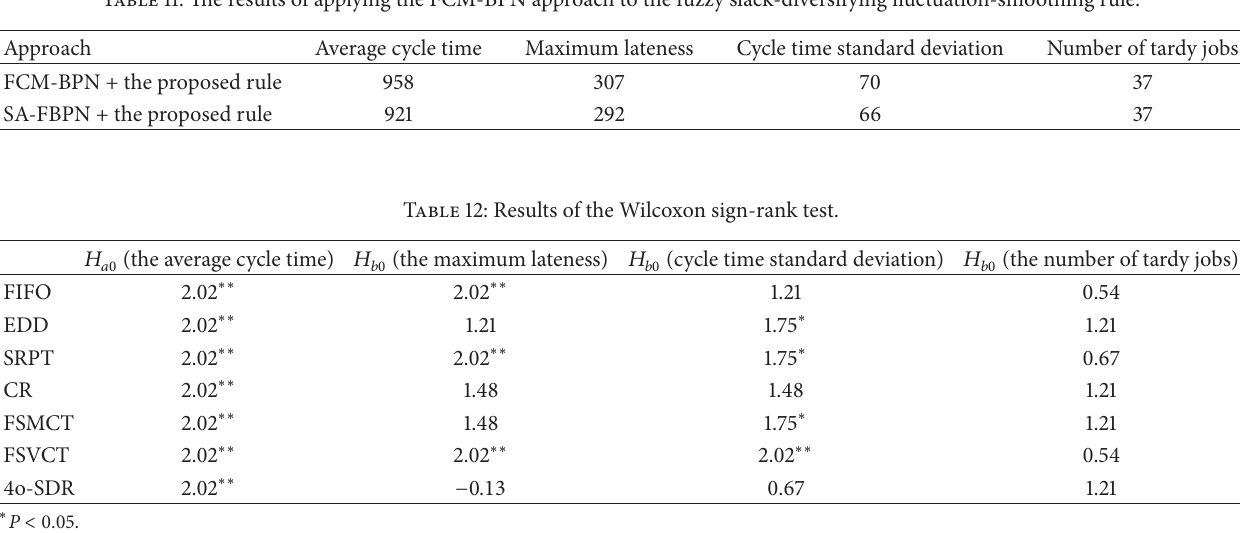
Table 11: The results of applying the FCM-BPN approach to the fuzzy slack-diversifying fluctuation-smoothing rule.